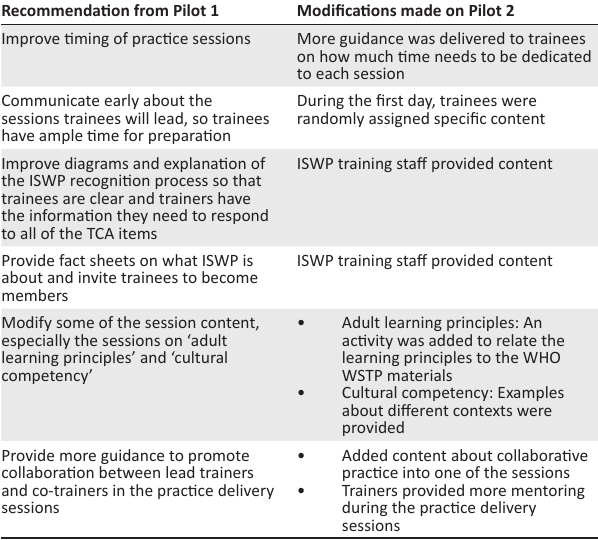
TABLE 6: Modifications made during the third pilot based on the second pilot